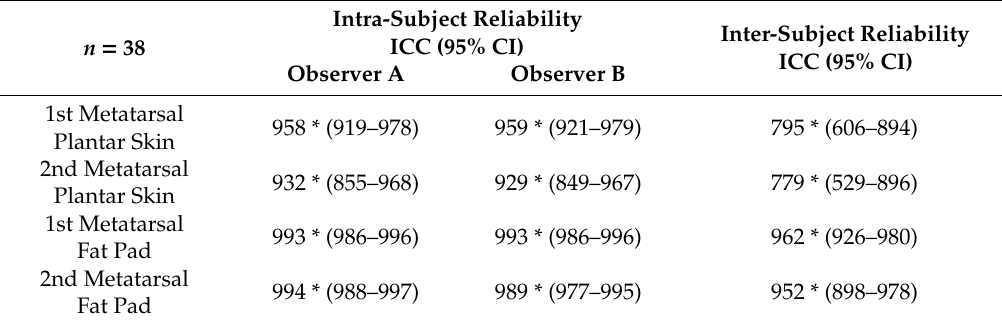
Table 1. Intra-subject and inter-subject reliability